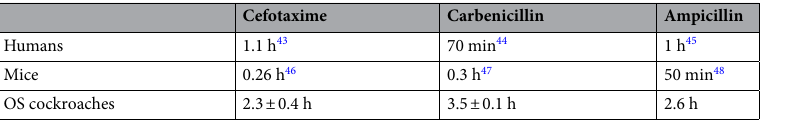
Table 2. Half-life of cefotaxime, carbenicillin, and ampicillin for humans (as reported in the literature) and OS